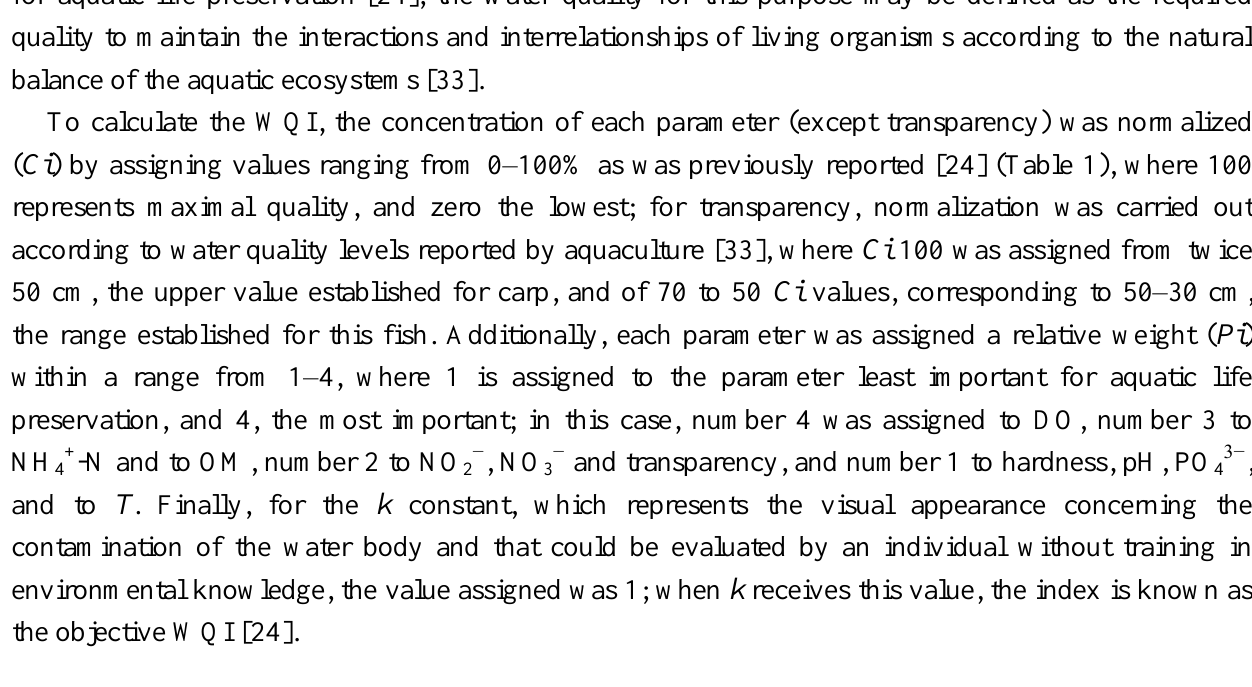
Table 1. Parameters used in the calculation of the WQI, relative weights assigned ( Pi ) to each parameter, and Ci values utilized in the